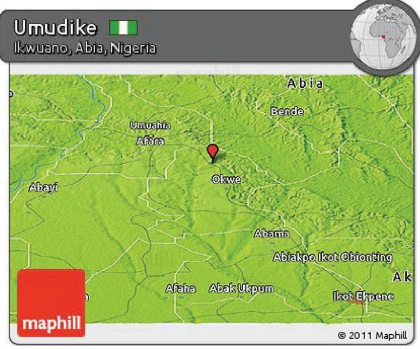
Figure 1: Geographical map of study area (source: